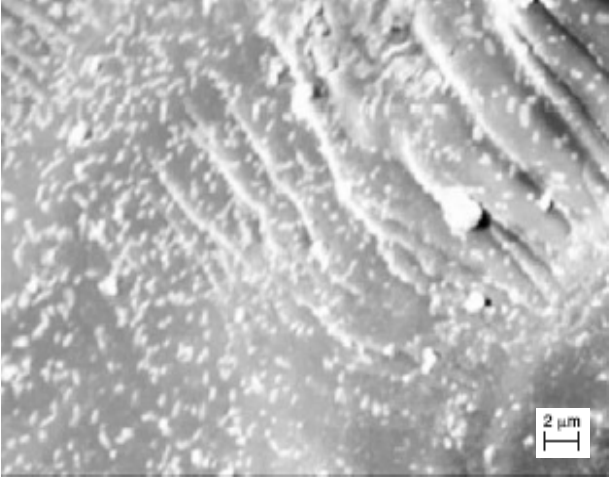
Figure 1. SEM micrograph of the surface of sago waste carbon, Magnification-